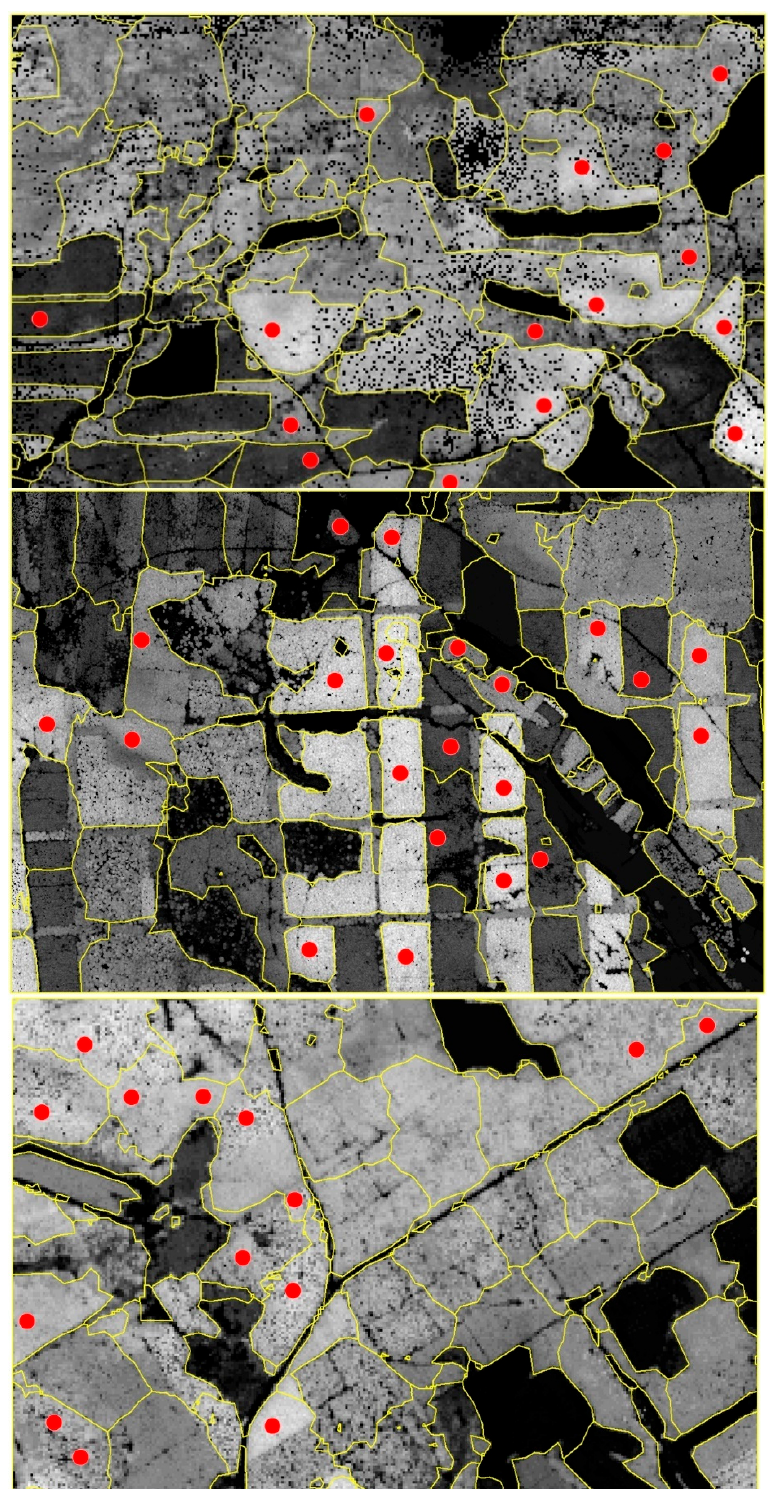
Figure 4. Stand delineation overlaid with the 95% percentile of the height distribution of the echoes (1 km × 1.5 km). A lighter tone indicates a higher value of the attribute. Red points represent sample plots and yellow lines are stand boundaries.